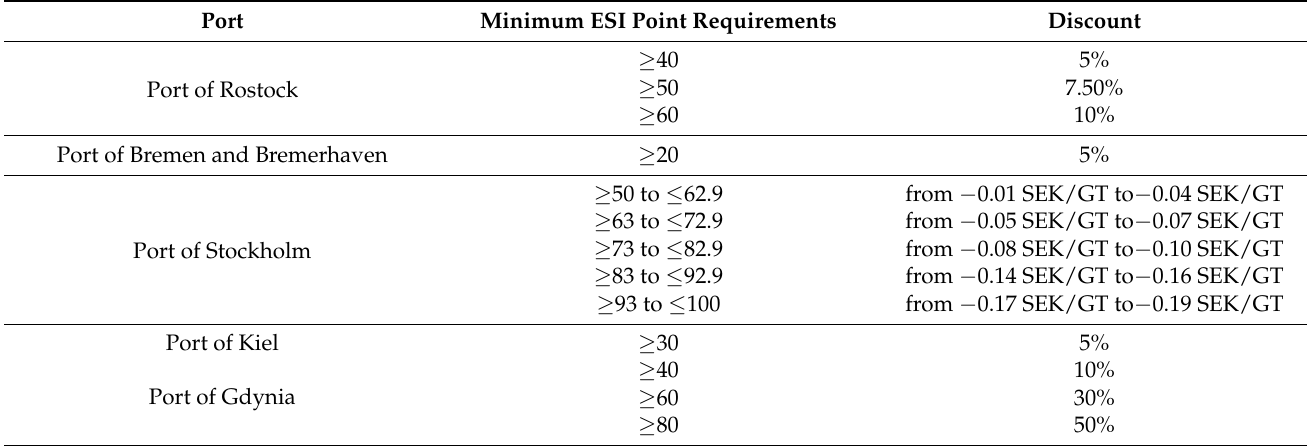
Table 2. Environmental Ship Index point requirements for reduced duty fees at selected ports in Northern